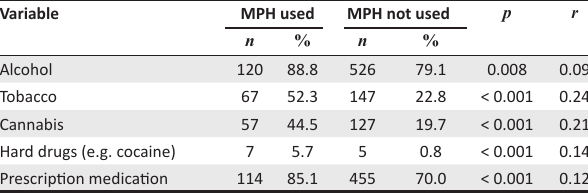
TABLE 2: Methylphenidate and use of other substances. Variable